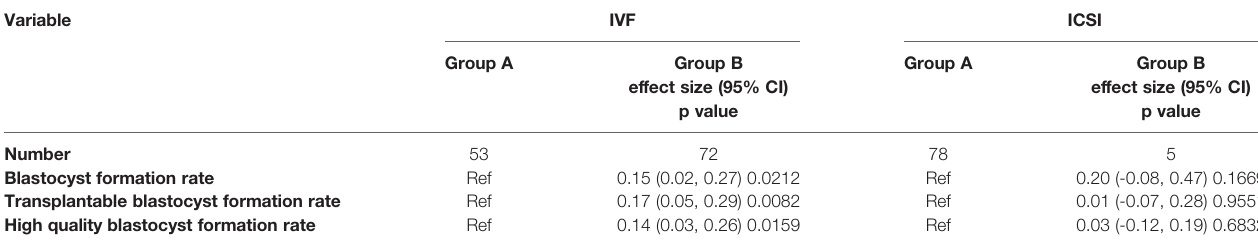
TABLE 2 | Subgroup analysis to explore the in fl uence of PPN embryos on the development of other embryos in the group culture system.